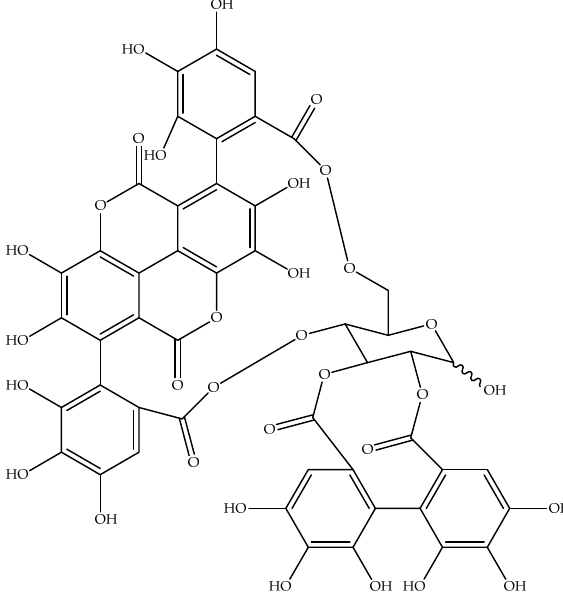
Figure 1. The structure of punicalagin, the main polyphenolic compound present in pomegranate.